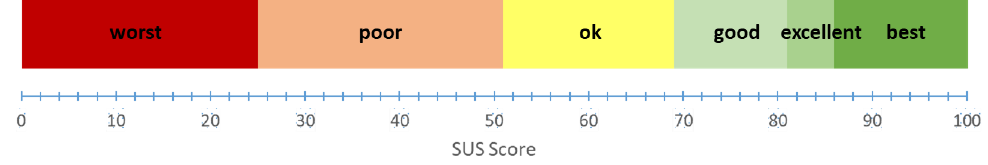
Figure 10. Adjectives associated with the raw scores of SUS test.